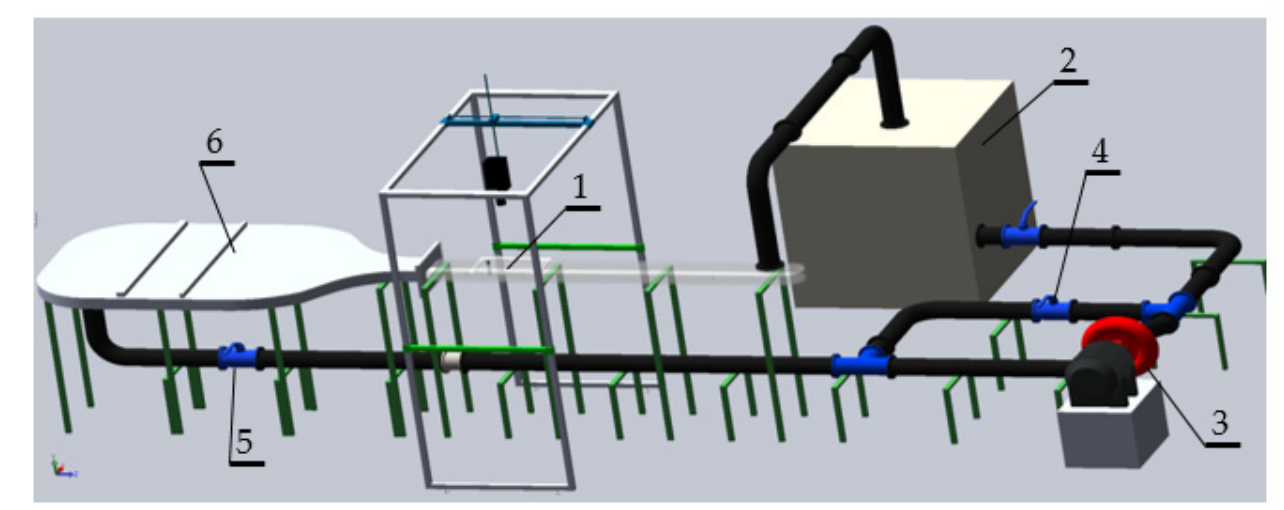
Figure 15. Experimental setup.